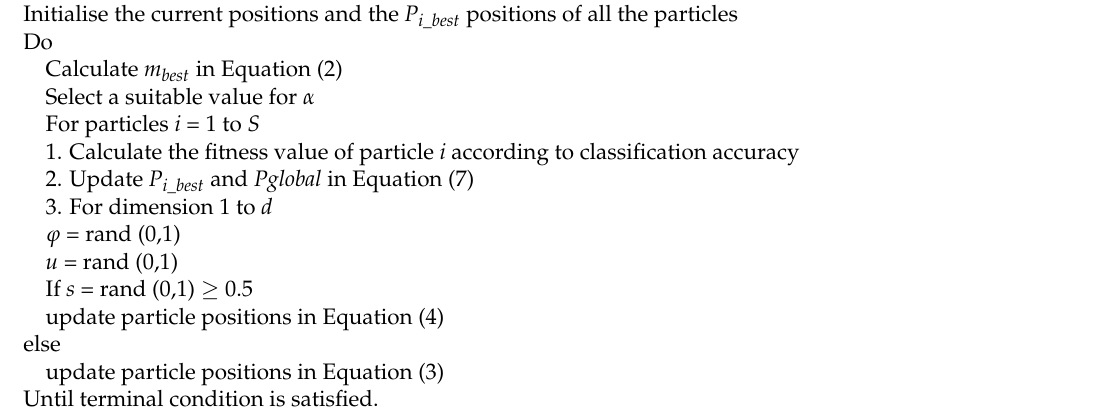
Table 2. Pseudocode for executing the QPSO algorithm [18,19].